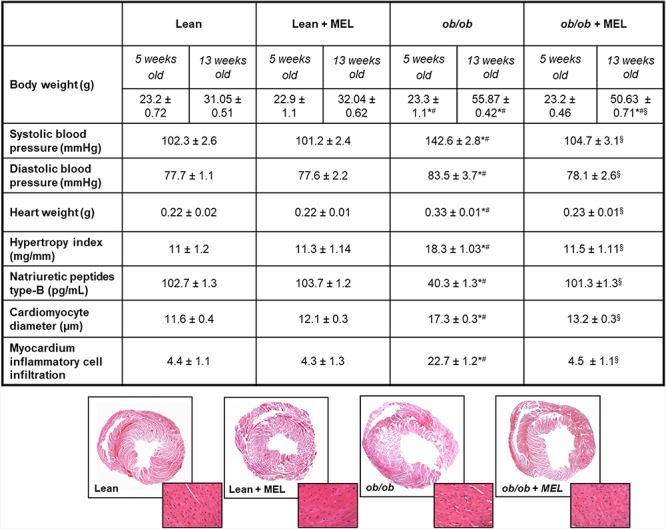
The table summarizes biometric and morphometrical values of all experimental groups. *p≤0.05 vs lean mice, #p≤0.05 vs lean mice supplemented with melatonin, and §p≤0.05 vs ob/ob mice. Photomicrographs show representative hematoxylin–eosin stained heart sections of lean, lean mice supplemented with melatonin, ob/ob mice, and ob/ob mice supplemented with melatonin. Scale bar: 20 μm. MEL, melatonin.